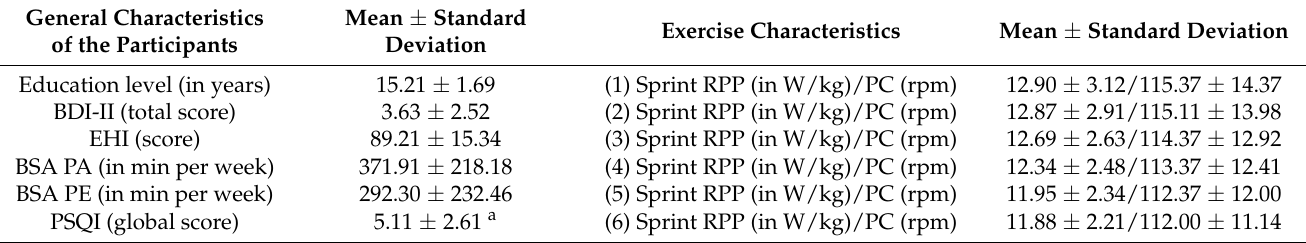
Table 1. Overview of the general characteristics of the